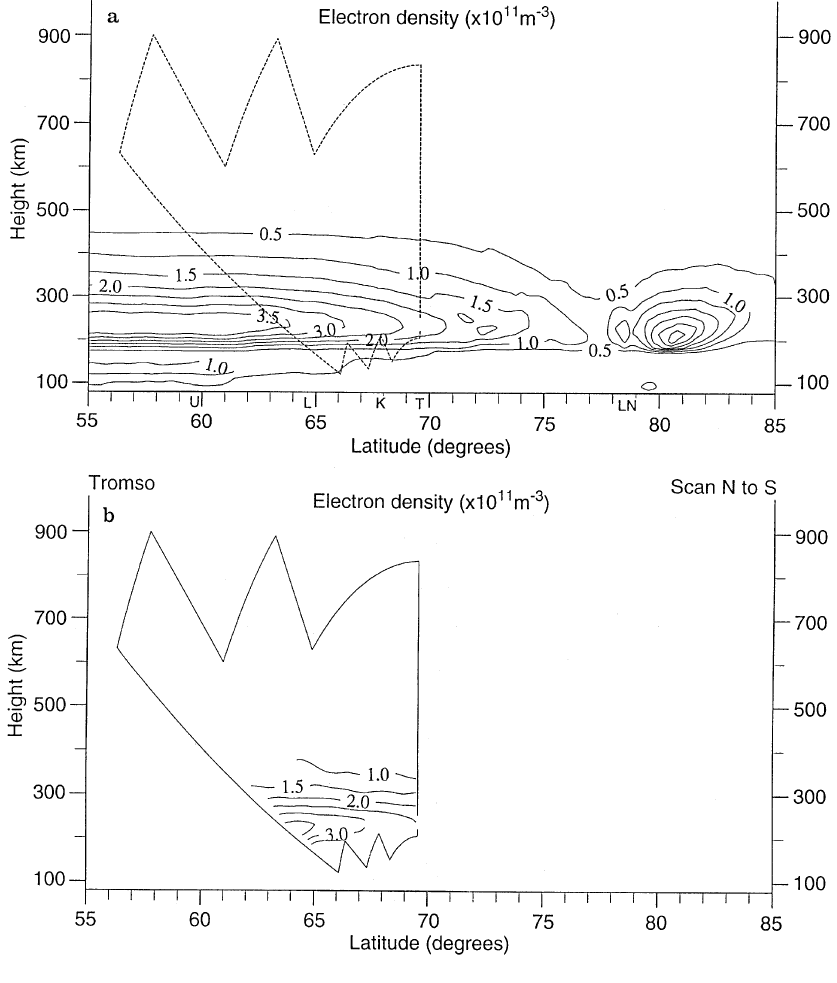
Fig. 6. a Tomographic image of electron density for a satellite pass at 1122 UT on